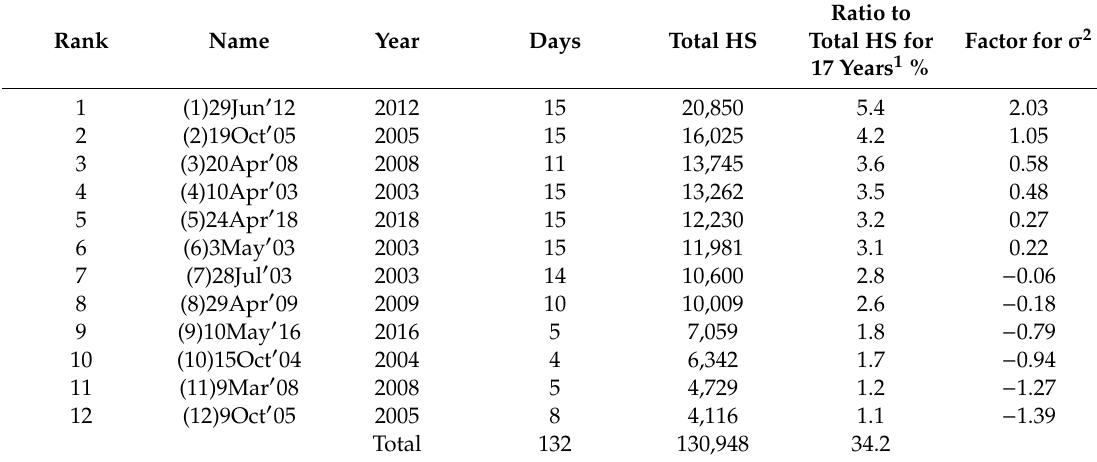
Table 1. The top 12 active fire-periods in the southern Khabarovsk Krai